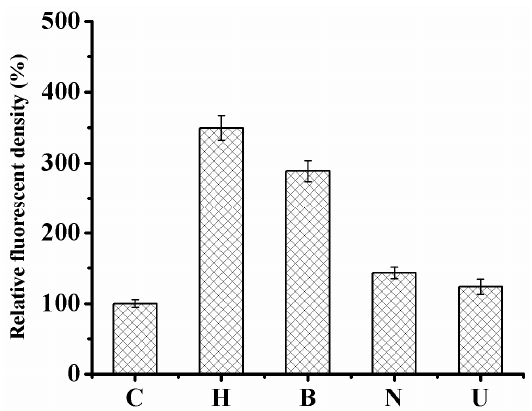
Figure 8. The quantification of fluorescence intensity of the oxidized product DCF in HaCaT cells is Figure presented in the bar graphs. C: Normal culture group; H: Only oxidative damage group; B: Blank- NLC-treated group; N: UB-NLC-treated group; U: Free UB-treated group. 2.5. Effect of UB-NLC on the Activity of Superoxide Dismutase (SOD) and Glutathione Peroxidase (GSH-PX)